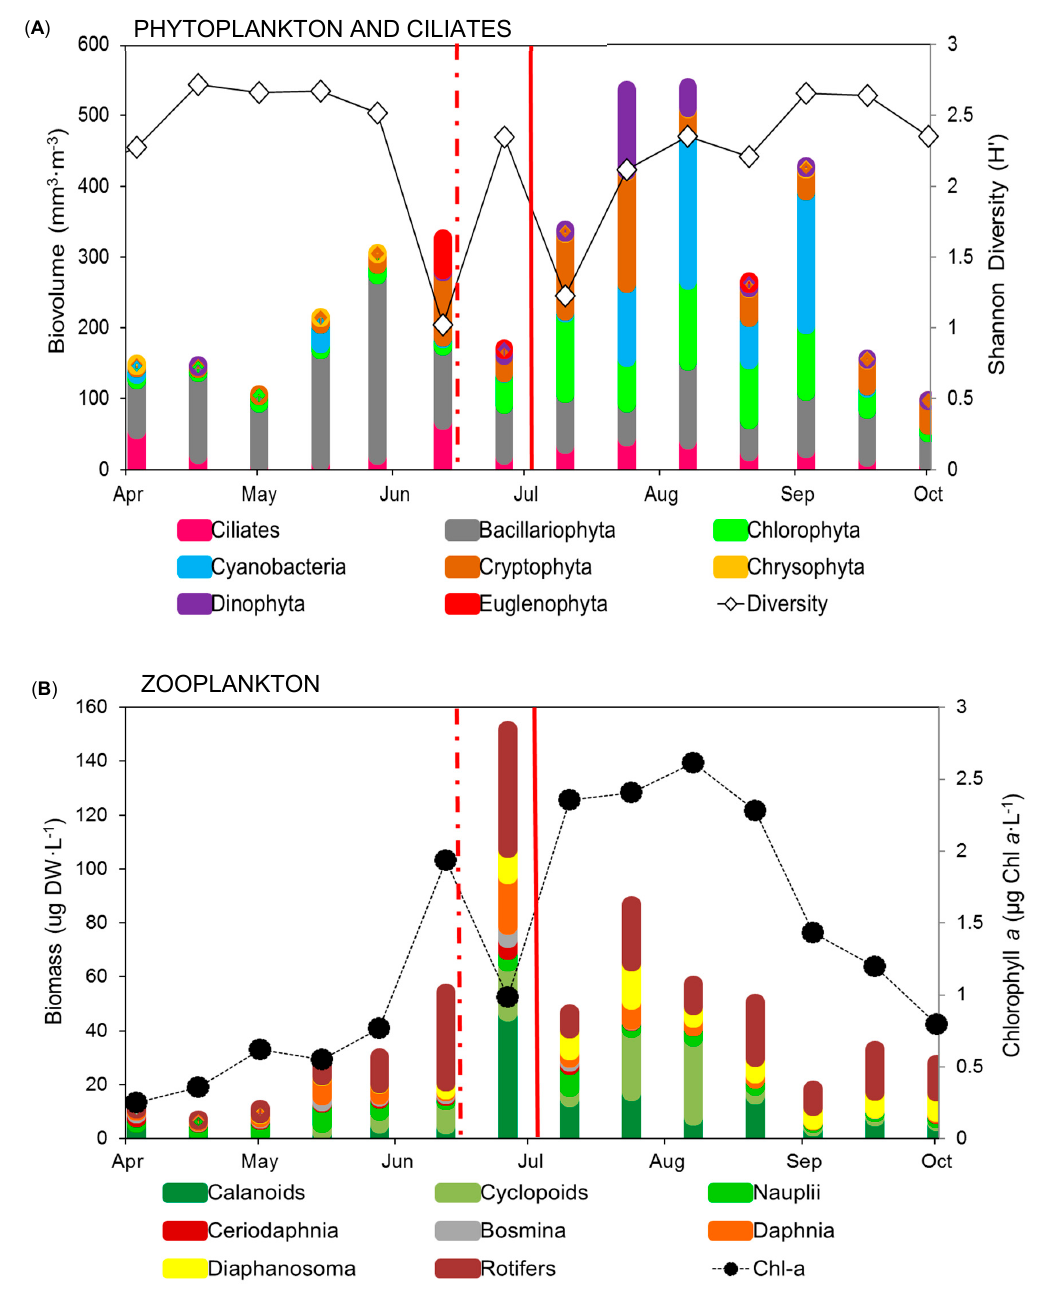
Figure 6. ( A ) Biovolumes (mm 3 ·m − 3 ) of different phytoplankton phyla and ciliates from 6 m integrated water samples and Shannon diversity index (H’) and ( B ) biomass (µg DW·L − 1 ) of different zooplankton taxa and chlorophyll a recorded in Lough Feeagh between April and October 2018. Dotted red lines indicate the Storm Hector event and solid red lines indicate when the Feeagh water column returned to more stable stratification conditions .